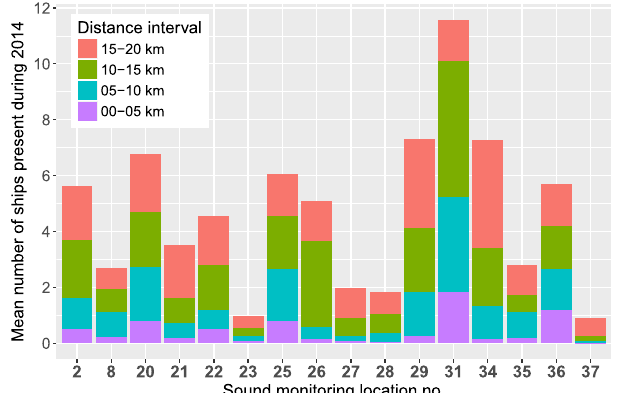
Figure 2. Average ship traffic intensity at different distance intervals within 20 km maximum range from the monitoring locations in 2014. The intensity calculation is based on 20 second time-regularised ship location data from the automatic identification system (AIS). The mean number of ships corresponds to the most likely number of ships within a distance interval at a randomly selected time during